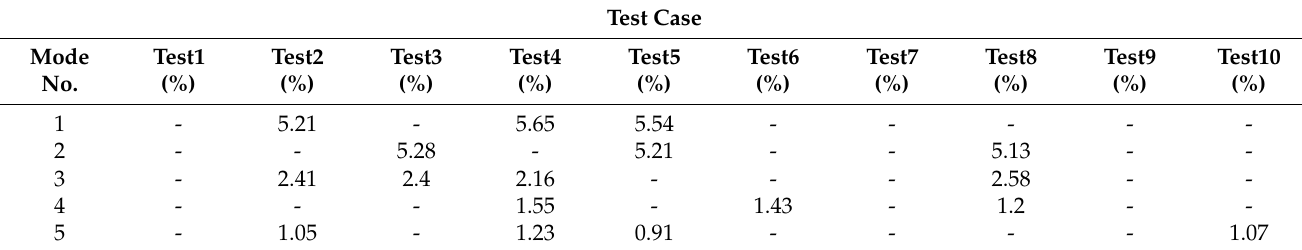
Table 5. Extracted damping ratios using the SSI method.